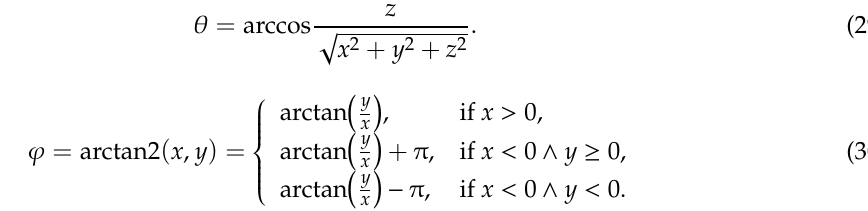
Figure 25. 1 st eigenvector (displayed as arrow) of a fiber orientation in 3D space described by the polar angle 𝜃𝜃 and the azimuthal angle 𝜑𝜑 (Eulerian angles) in a Cartesian coordinate system.